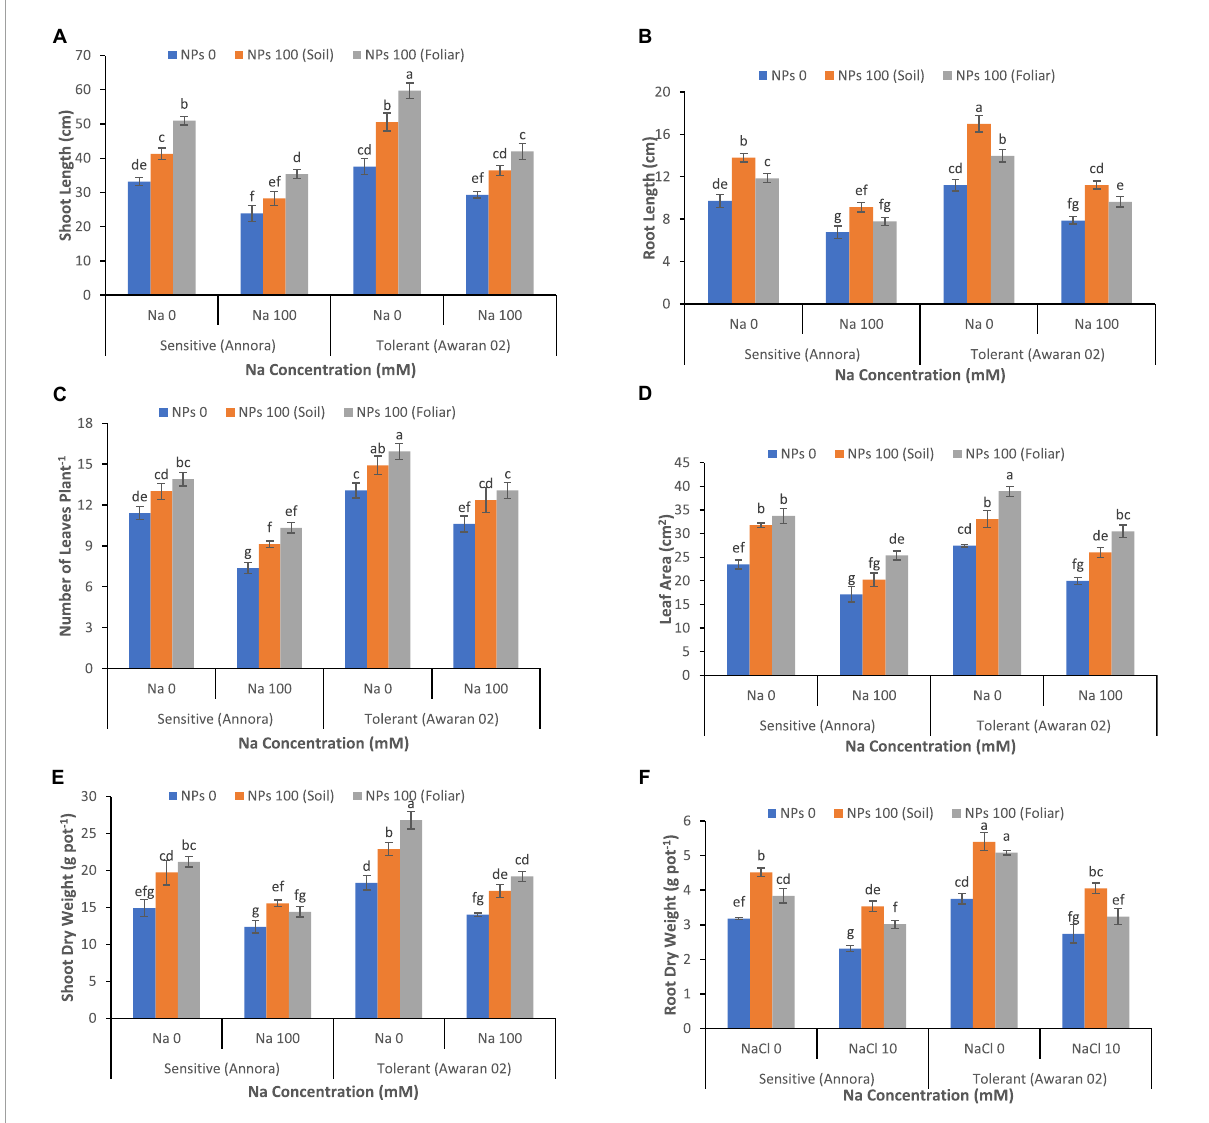
FIGURE1 Effects of different concentrations of NaCl (0 and 100 mM) and ZnO NPs (0, 100 mg kg − 1 soil, and 100 mg L − 1 foliar) on (A) shoot length, (B) root length, (C) number of leaves per plant, (D) leaf area, (E) shoot dry weight, and (F) root dry weight of two barley genotypes Annora (salt sensitive) and Awaran 02 (salt tolerant). Values are expressed as means of three replicates with standard deviations. Different letters indicate that values are significantly different at a p -value <